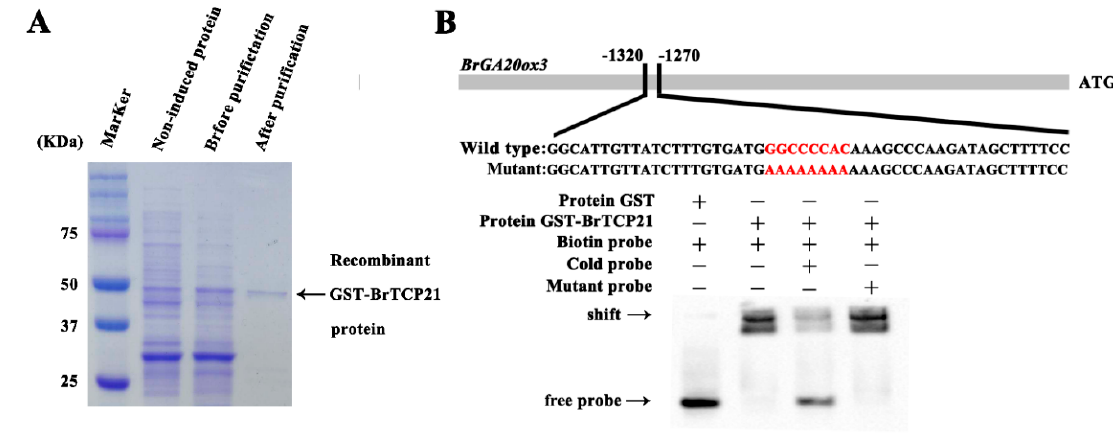
Figure 5. BrTCP21 directly binds to BrGA20ox3 promoter. ( A ) SDS-PAGE gel stained with Coomassie brilliant blue demonstrating affinity purification of the recombinant GST-BrTCP21 protein used for electrophoretic mobility shift assay (EMSA). ( B ) EMSA showing the binding of BrTCP21 to the TCP binding site of the BrGA20ox3 promoter. Purified glutathione-S-transferases (GST)-tagged BrTCP21 protein were incubated with the biotin-labeled wild-type probe containing the TCP binding site, and the DNA–protein complexes were separated on native polyacrylamide gels. Sequences of both the wild-type and mutated probes are shown at the top of the image (wild-type and mutated TCP binding site are marked with red letters). Shifted bands, suggesting the formation of DNA–protein complexes, are indicated by arrows. ‘‘ − ’’ represents absence, ‘‘+’’ represents presence. Competition experiments were carried out by adding cold probes with unlabeled DNA fragments with the same or mutant sequences.